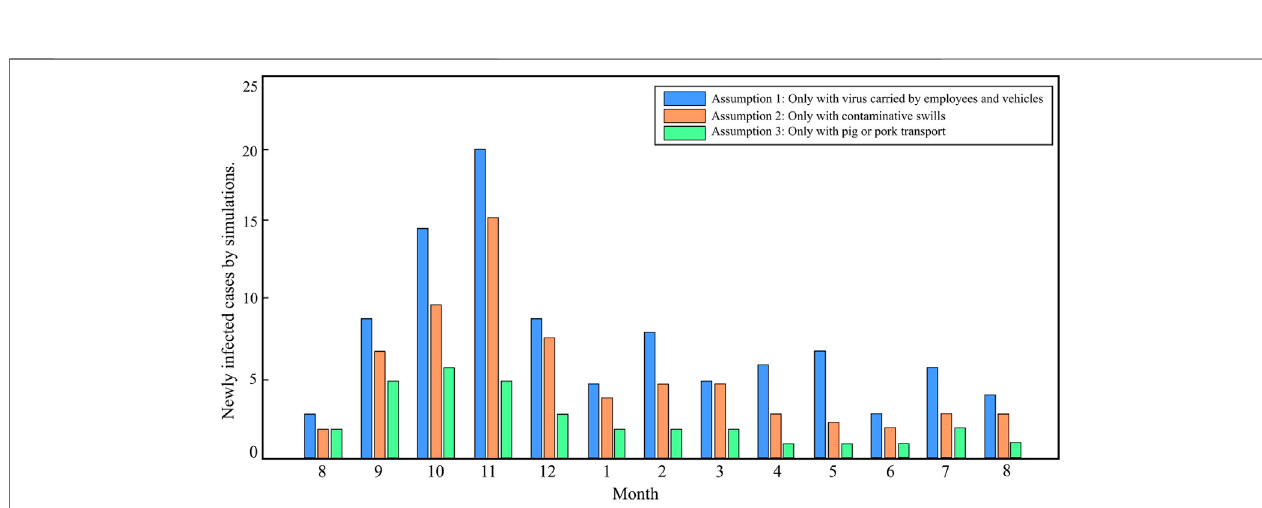
FIGURE7| Partialrankcorrelationcoef fi cients(PRCCs)forparameters β ff , β fh , β vf , β wf withrespecttothemaximumlikelihood L ( u , t )associatedwithallthedetected possible infection sources of (A) infected pig farm node f 20 and (B) infected slaughterhouse node h 6 .